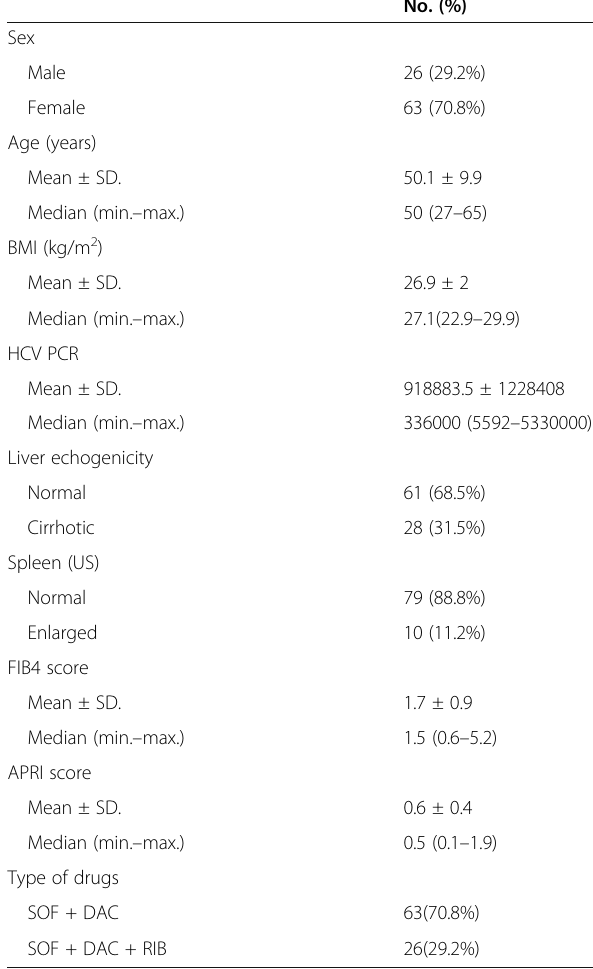
Table 1 Distribution of the studied cases according to different clinical parameters ( n =